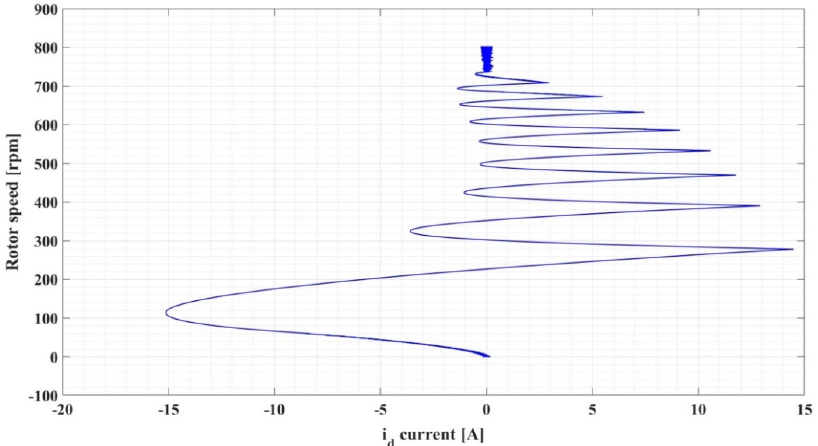
Figure 16. Image of the phase plan for PMSM variable structure with switching signal type 1: rotor speed versus i d current.